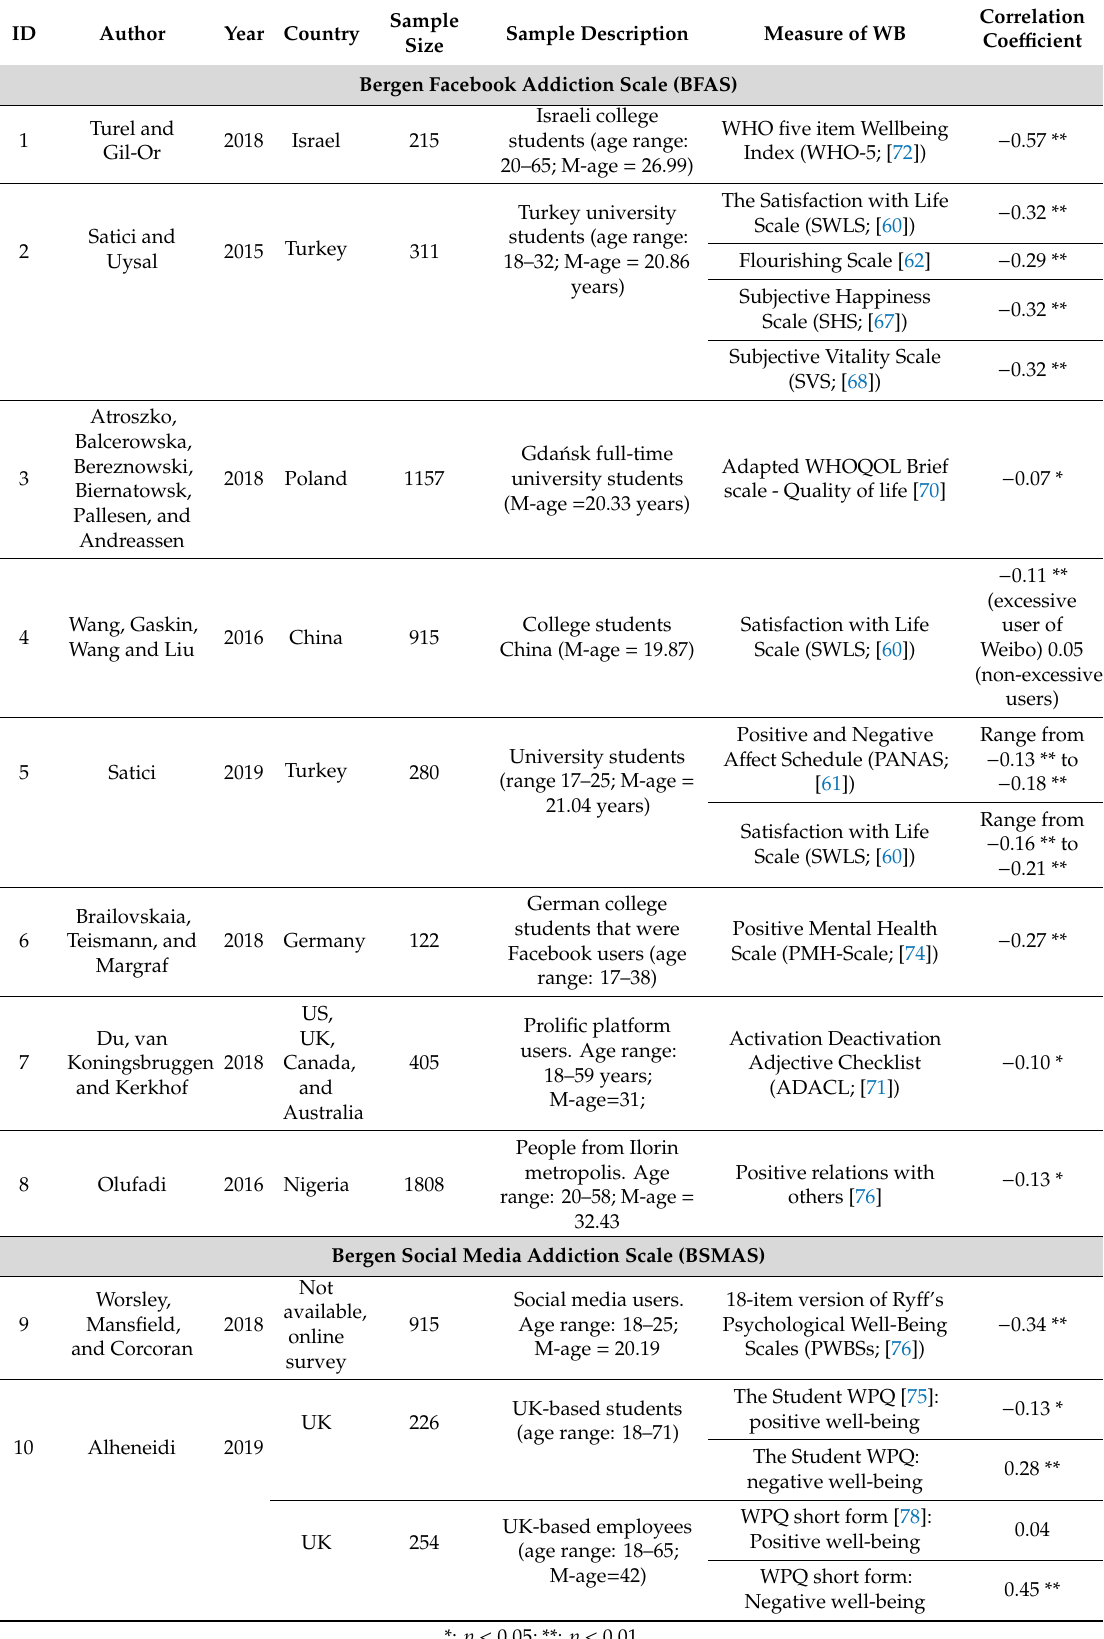
Table 1. The ten studies included in which the well-being measures have been used jointly with BFAS or